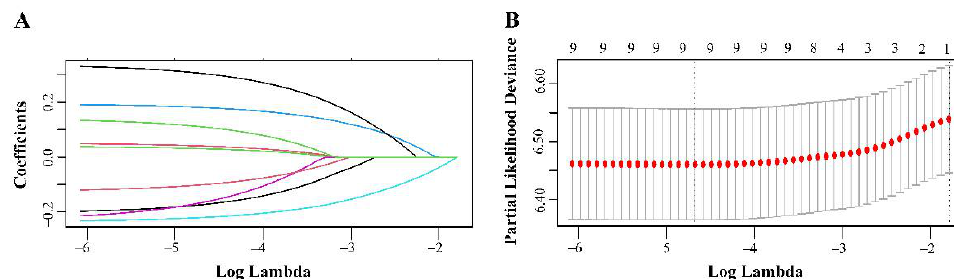
Figure 2. Prognostic indicators selection using the LASSO model analysis. LASSO coefficient profiles of nine covariates against the log (Lambda) sequence for OS ( A ). tuning parameter (Lambda) selection in the LASSO model used 10-fold cross-validation via minimum criteria for OS ( B ). LASSO, least absolute shrinkage and selection operator; OS, overall survival. Table 2. LASSO-penalized multivariate Cox regression analysis of